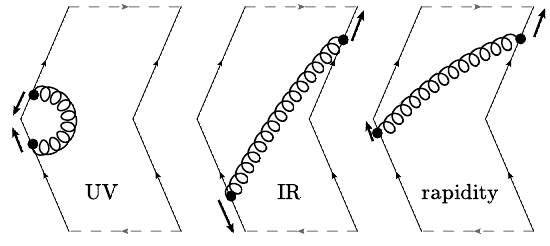
Figure 3 . Divergent con(cid:12)gurations of the TMD soft factor at one-loop. The arrows indicate the direction in which the position of the particle should be